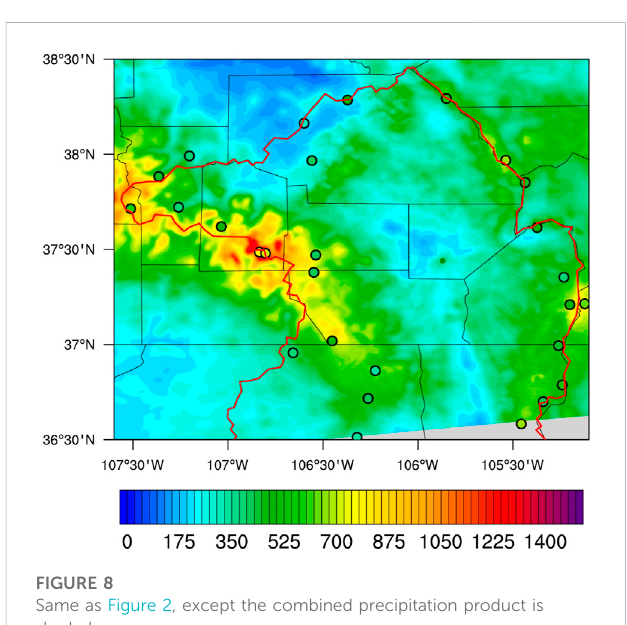
FIGURE 8 Same as Figure 2, except the combined precipitation product is